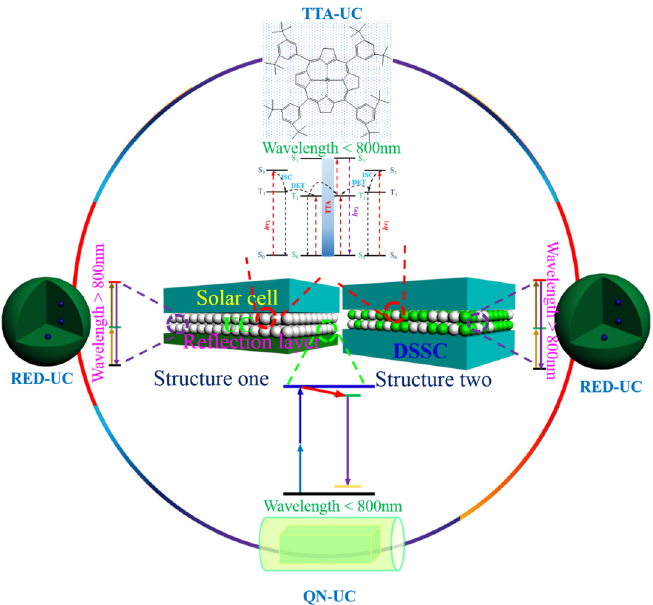
Figure 6. A schematic illustration of the usage of three typical upconversion materials in solar cells using two configurations. (Rare-earth upconversion, RED-UC; Upconversion in quantum nanostructure, QN-UC; Triplet-triplet annihilation upconversion,